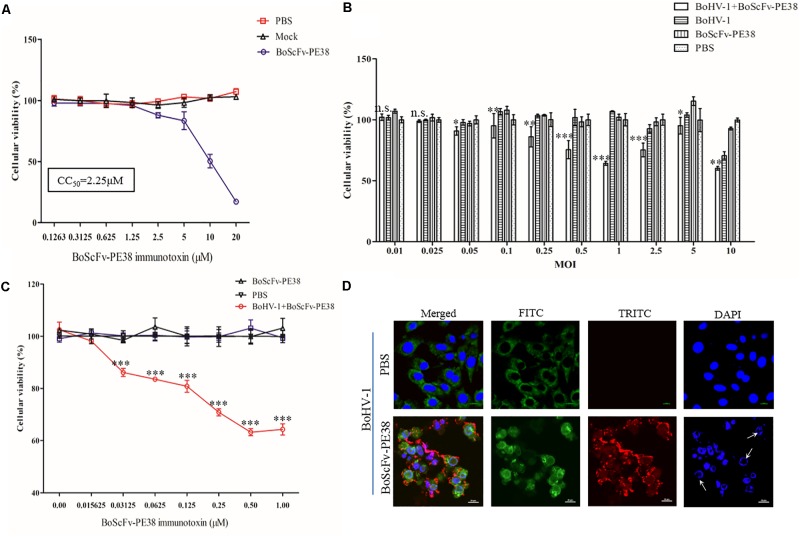
Cytotoxicity of BoScFv-PE38 in BoHV-1-infected MDBK cells. (A) Determination of the cytotoxic concentration of BoScFv-PE38 in MDBK cells. MDBK cells were seeded in 96-well plates and cultured to 90% confluency at 37°C for 18–24 h. Then, BoScFv-PE38 (0.1263–20.0 μM) was add to the culture medium, followed by cultivation at 37°C for 24 h, and the cellular viability was measured. (B) Cytotoxicity of BoScFv-PE38 in MDBK cells infected with different MOIs of BoHV-1. MDBK cells were seeded in 96-well plates and cultured to 90% confluency at 37°C over 18–24 h. Then, the MDBK cells were infected with BoHV-1 (MOI was from 0.01 to 10), added to the culture medium, and cultivated 37°C for 1.5 h. The culture medium was subsequently replaced with new culture medium containing 1% FBS and BoScFv-PE38 (1 μM); the MDBK cells were cultured for an additional 24 h; and cellular viability was measured. (C) Dose-dependent cytotoxicity of BoScFv-PE38 in BoHV-1-infected MDBK cells. MDBK cells were seeded on cover slips in 96-well plates and cultured to 90% confluency at 37°C for 18–24 h. Then, the MDBK cells were infected with BoHV-1 (MOI = 1), added to the culture medium, and cultivated at 37°C for 1.5 h. The culture medium was subsequently replaced with new culture medium containing 1% FBS and BoScFv-PE38 (1 μM); the MDBK cells were cultured for 24 h; and cellular viability was measured. All statistical analyses were performed via analysis of variance (ANOVA) using SPSS software, version 18.0, and the fitting curves of various concentrations of BoScFv-PE38 were drawn with GraphPad Prism 5.0. “n.s.” represents no statistically significant differences (P > 0.05). “∗” represents statistically significant differences (P < 0.05). “∗∗” represents statistically significant differences (P < 0.01). “∗∗∗” represents statistically significant differences (P < 0.001). (D) Karyomorphism of BoHV-1-infected MDBK cells after treatment with BoScFv-PE38. MDBK cells were seeded on cover slips in six-well plates and cultured to 50% confluency at 37°C for 18–24 h. Then, the MDBK cells were infected with BoHV-1(MOI = 1). After 1.5 h, the culture medium was replaced with new culture medium containing 1% FBS and BoScFv-PE38 (1 μM) or PBS as the negative control, and the MDBK cells were cultured for 24 h. The MDBK cells were subsequently fixed with 4% paraformaldehyde, permeabilized with 0.1% Triton X-100 for 1 h, and blocked with 3% bovine serum albumin. The cells were then incubated with anti-BoHV-1 bovine serum for 1 h at 37°C, washed three times with PBS, incubated with the FITC-labeled Rabbit anti-bovine antibody at 37°C for 1 h, washed three times with PBS once more, and finally incubated with the Alexa Fluor 555-anti-His antibody at 37°C for 1 h. Nuclei were counterstained with DAPI (blue). Cell samples were examined with a fluorescence microscope (Leica EL 6000). The karyomorphism of MDBK cells was observed under a CLSM (Leica).